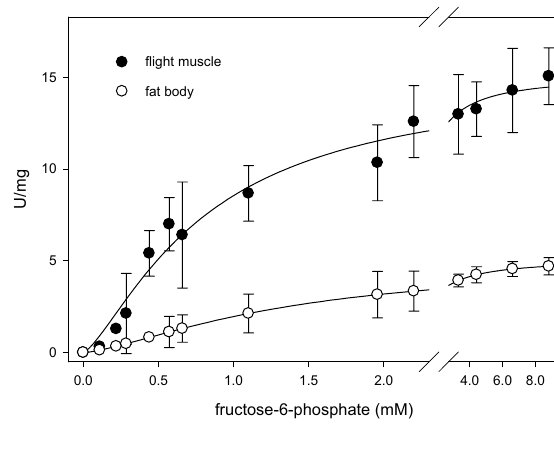
Fig. 2 – Effects of fructose 6-phosphate on PFK activity from fat body and muscle homogenates. PFK activity of flight muscle (filled triangles) or fat body (empty circles) was measured as described on Materials and Methods, in the presence of 1 mM ATP and different fructose 6-phosphate concentrations. Values are means ± SE of at least six independent experiments.